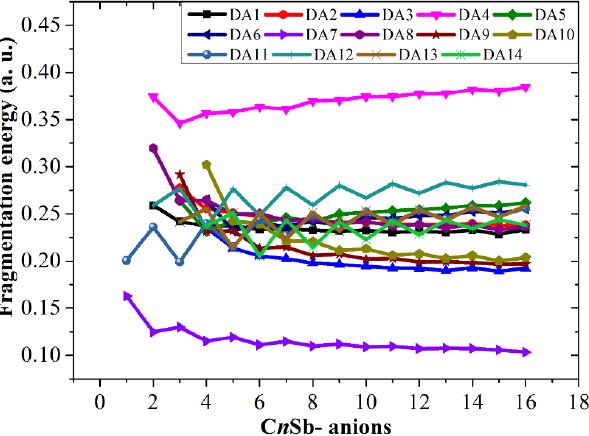
Figure 17. Fragmentation energies of C n Sb − anions. DA x corresponds to different dissociation channels, as shown in the text.